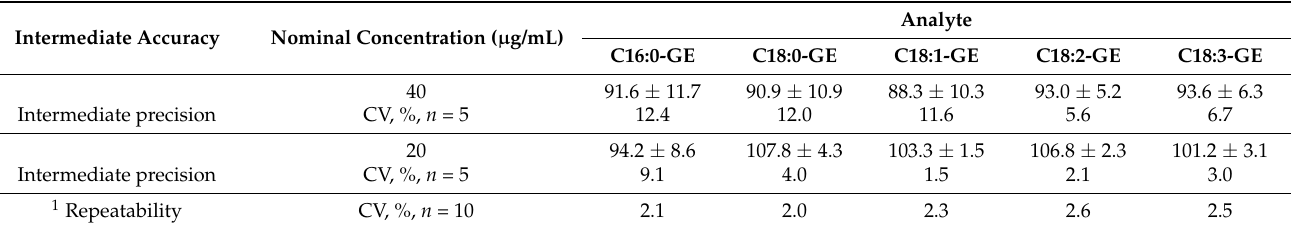
Table 5. Intermediate precision and accuracy data of five glycidyl ester (GE) species in oil samples. Intermediate